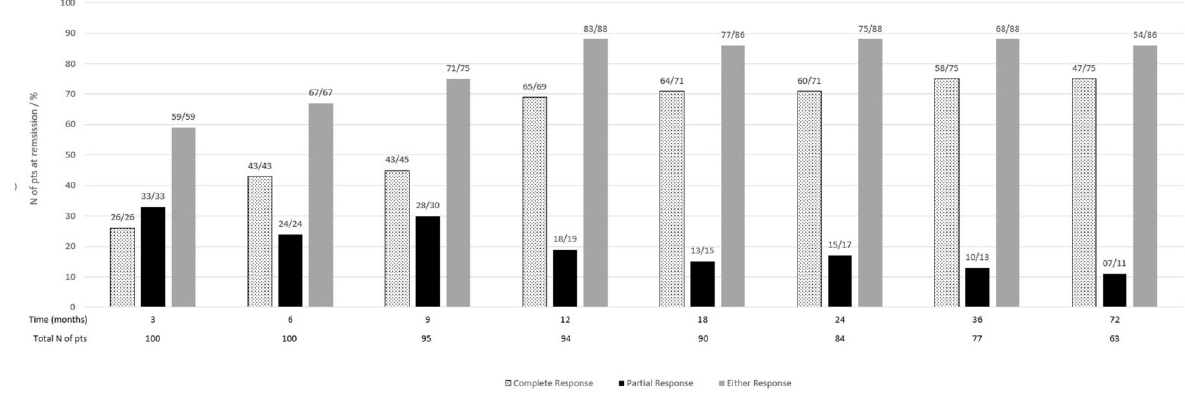
Figure 1. Patients with a renal response at different time points during follow-up. Table 2. Predictors of time to complete response.